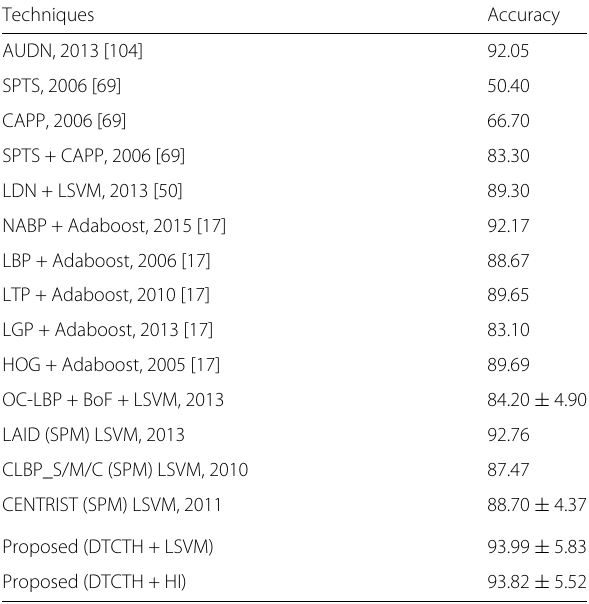
Table 11 7-class expression recognition rate (%) in